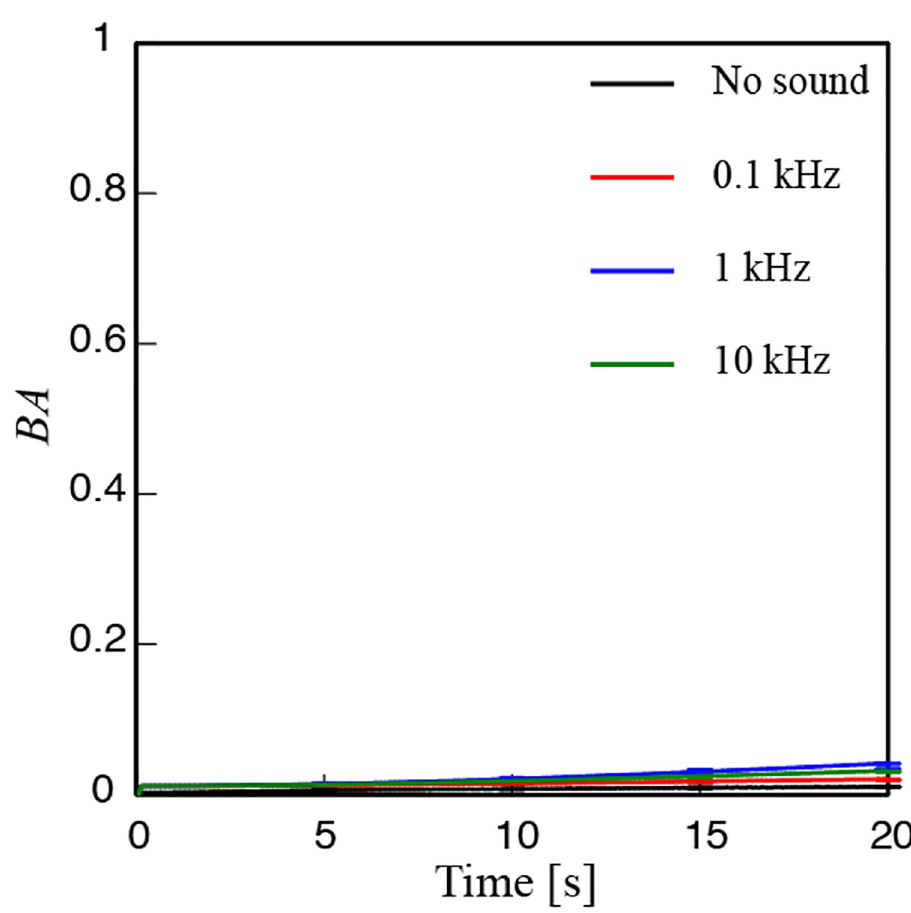
Fig 5. Temporal variation of BA from a phantom object of paper under exposure to different frequency sounds used in the experiment. Error bars correspond to standard error of the mean.